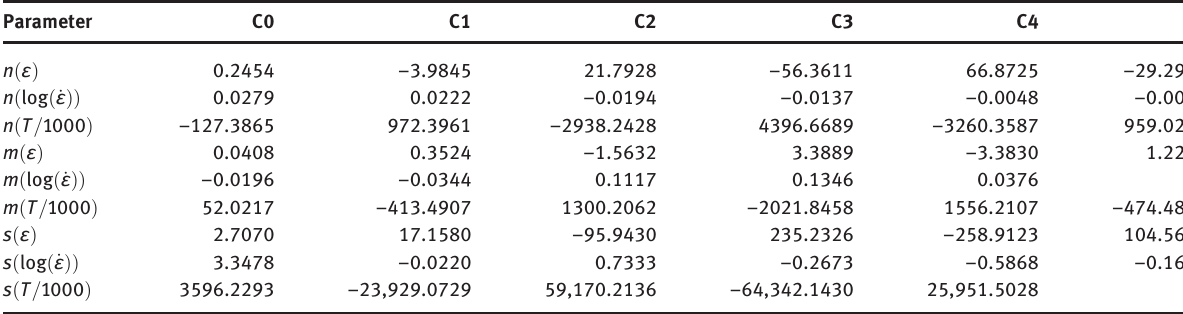
Table 3: The fitting coefficients of the fifth power of polynomial about n, m, s . Parameter